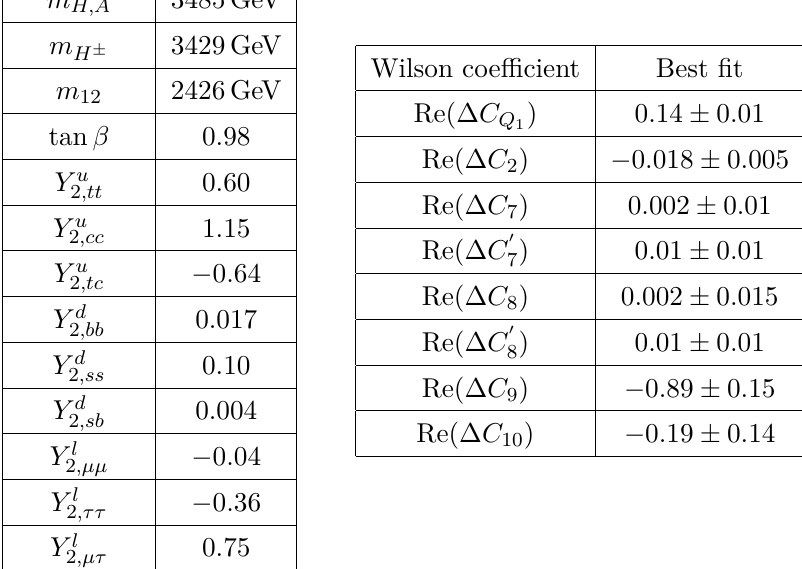
) given that at tree level and in the alignment limit Re(∆ C Q 1 ) = Re(∆ C 0 ) = − Re(∆ C 0 ) . The uncertainties on the WCs were Q 1 Q 2 1